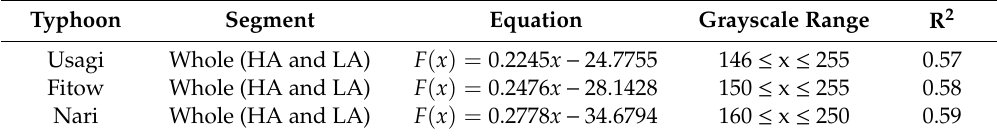
Table 4. The whole linear model for Usagi, Fitow, and